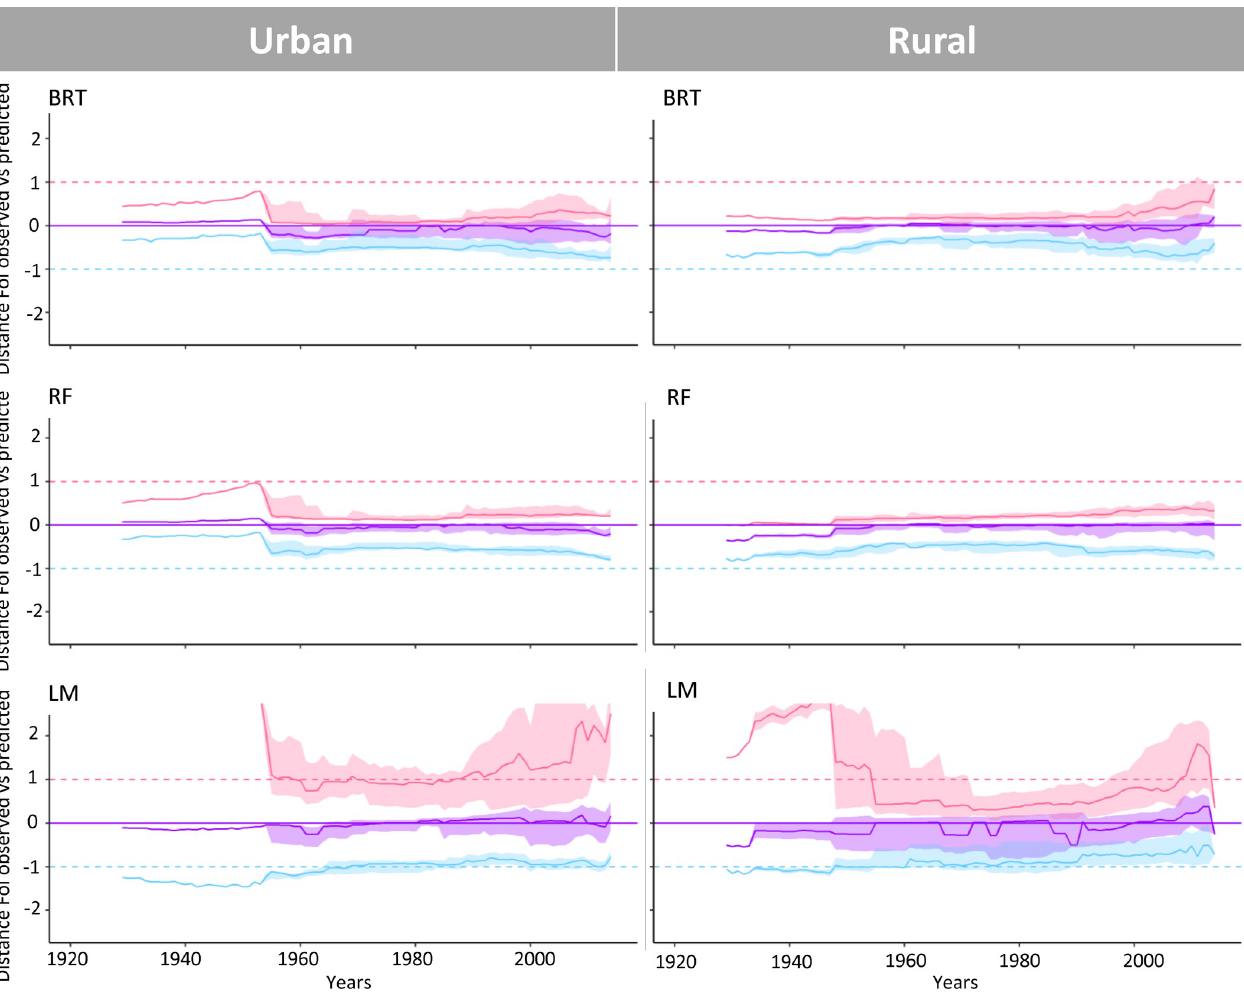
Fig 5. Standardised comparisons of ‘observed’ and predicted distributions across serosurveys and by setting type. Comparisons were made for two Machine Learning (Boosted Regression Trees (BRT) and Random Forest (RF)) methods (upper and middle panels) and a Linear Model (LM) framework (lower panel) using log-transformed (log) Force-of-Infection (FoI) estimates from the FullPostFoI approach for urban and rural Chagas disease settings in Colombia across 9 decades. The solid lines and envelopes show standardised distances between FoI ‘observations’ and predictions, with purple-colour lines representing the median, and the pink and blue lines representing, respectively, the upper and lower bounds of the 95%CrI. If medians and 95% confidence bounds of the predictions matched exactly the corresponding measures for all the ‘observations’ across serosurveys, then the solid and dashed lines would fully